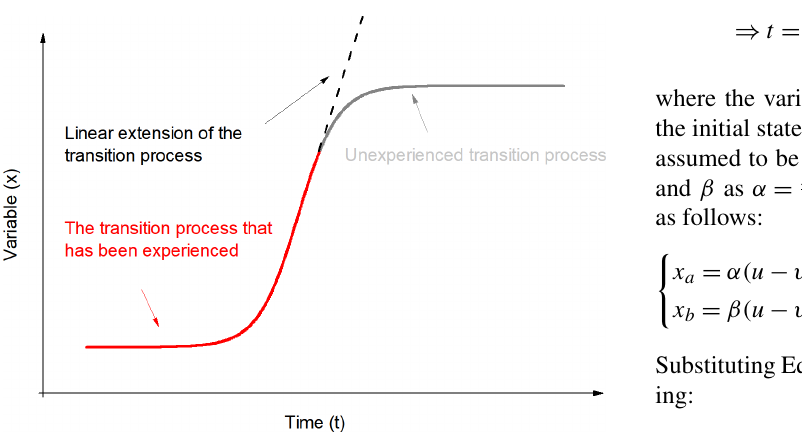
Figure 4. The schematic diagram of the prediction